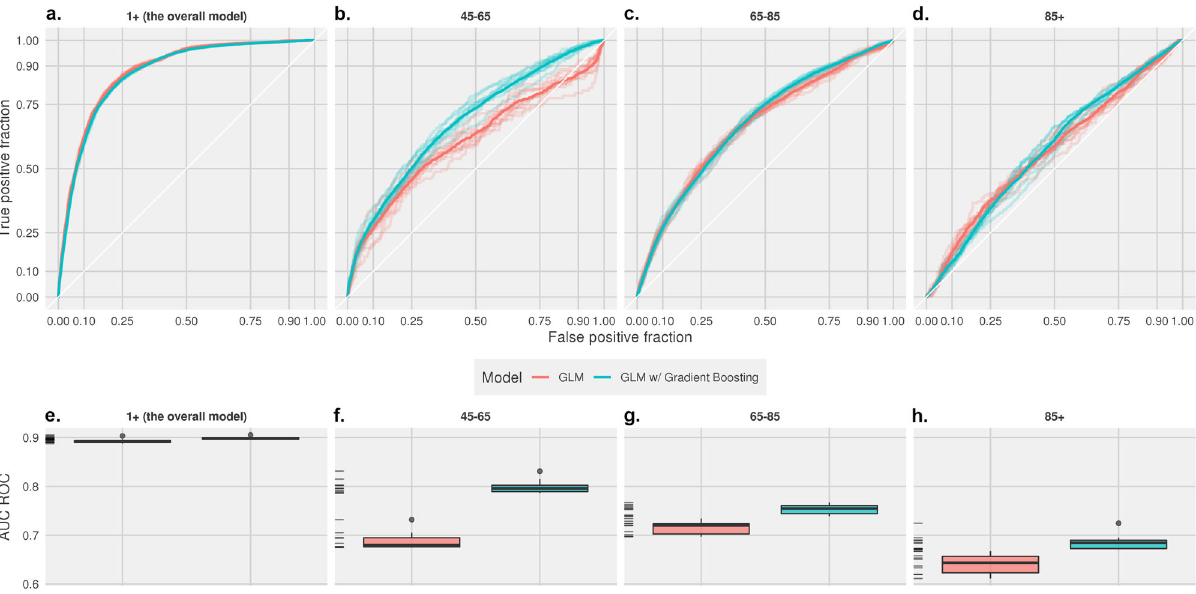
Fig. 1 Comparing the classi fi cation performance between the boosting and standard GLM (binomial logistic) models. a – d The ROC curves for the overall 45 – 65, 65 – 85, and 85 + models, respectively. e – h The area under the ROC curves for the overall, 45 – 65, 65 – 85, and 85 + models.